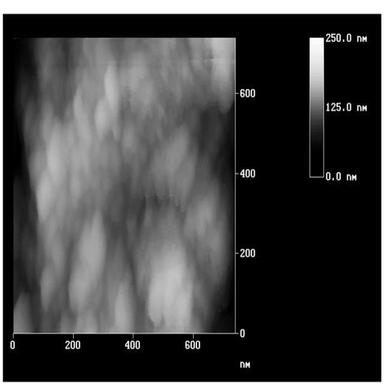
Larger (a) and smaller (b) length-scale AFM images of typical samples of G1 sol-gel silica showing the pore-scale morphology of the materials and the typical constituent particle size.